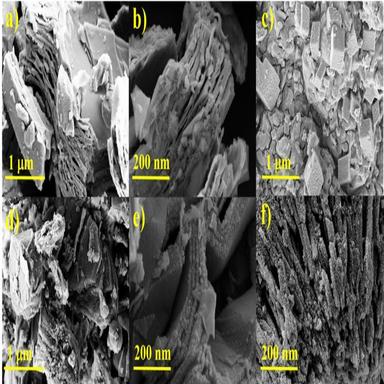
FE-SEM images of (a–b) MXene, (c) MCS, and (d–f) MCS-MXene (1:2) hybrid at different magnifications.